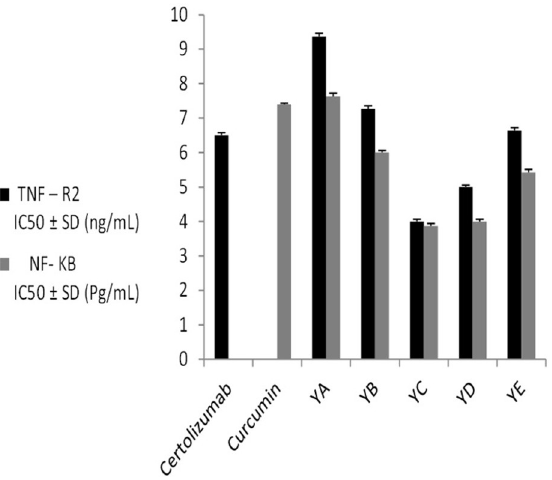
Fig 1. The effect of different fruit extracts on anti-inflammatory markers (TNF-R2 and NF- B). K https://doi.org/10.1371/journal.pone.0282246.g001 The extracted ion chromatogram for cyanidin derivatives having a base peak at m/z 287 showed two peaks at m/z 449.1080 and 449.1083 at R 2.64 and 3.97, respectively. These were t assigned to cyanidin galactoside followed by cyanidin glucoside due to the preferential earlier elu- tion of galactosides [8]. Pelargonidin hexoside was detected in the positive mode at m/z 433.1140 and confirmed through the ms2 base peak at m/z 271 upon the loss of the hexose moiety. Flavonoids. Several flavonoid glycosides and aglycones were detected, mainly in the nega- tive mode. Quercetin diglucoside (rutin) was detected in both modes and was confirmed com- pared to the standard sample using HPLC (Fig 3). It was observed as deprotonated and protonated molecular ions at m/z 609. 1483 and 611.1608. Fragmentation in the positive ion mode showed the base peak for the quercetin aglycone at m/z 303 and the intermediate peak at 465 due to the loss of the rhamnose moiety [M+H-146] [28]. Later, the monoglucoside querce- tin hexoside was detected in the positive mode at its charged molecular ion at m/z 465.1028 at 6.81 min. A tetrahydroxyflavone hexoside was detected at 8.9 min as its deprotonated